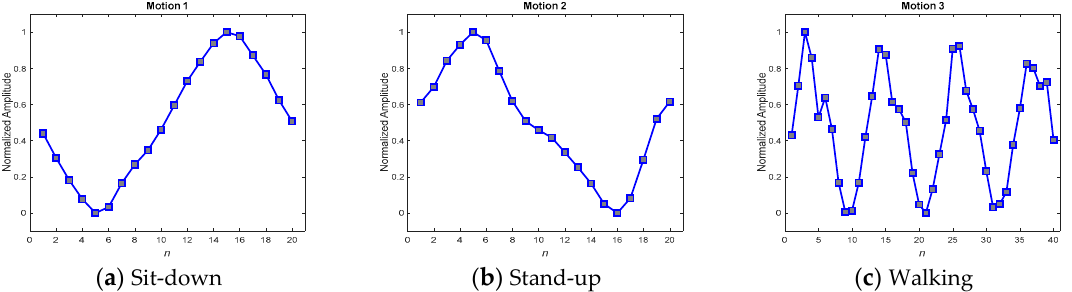
Figure 15. Averaged MPPs for motions 1–3, generated by the DFT interpolation equalizer.